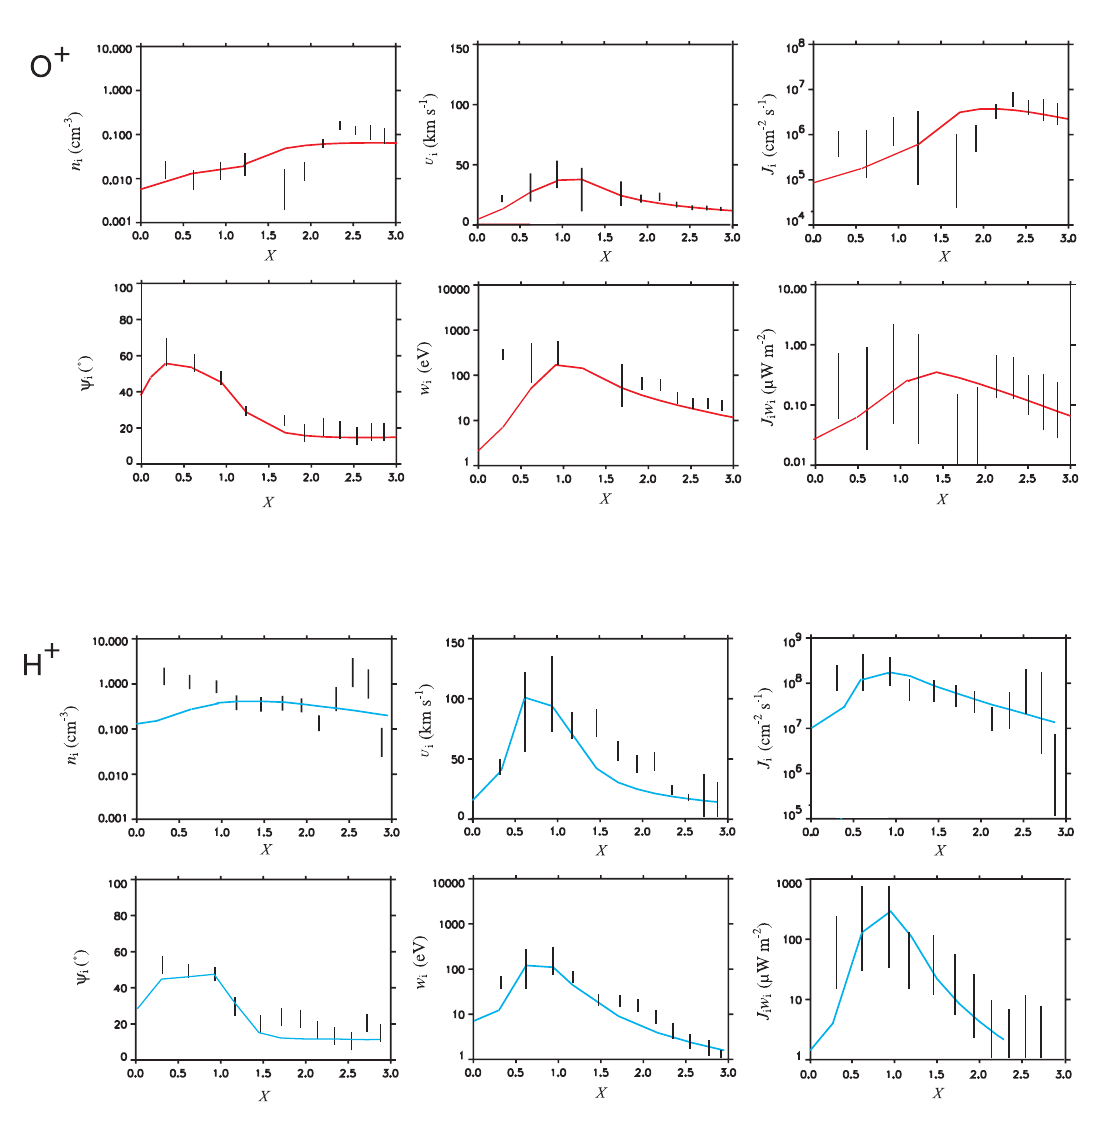
Fig. 8. Comparisons of experimental ion moments along the satellite track for event 1 with those from a numerical simulation (solid curves) for O + (top) and H +